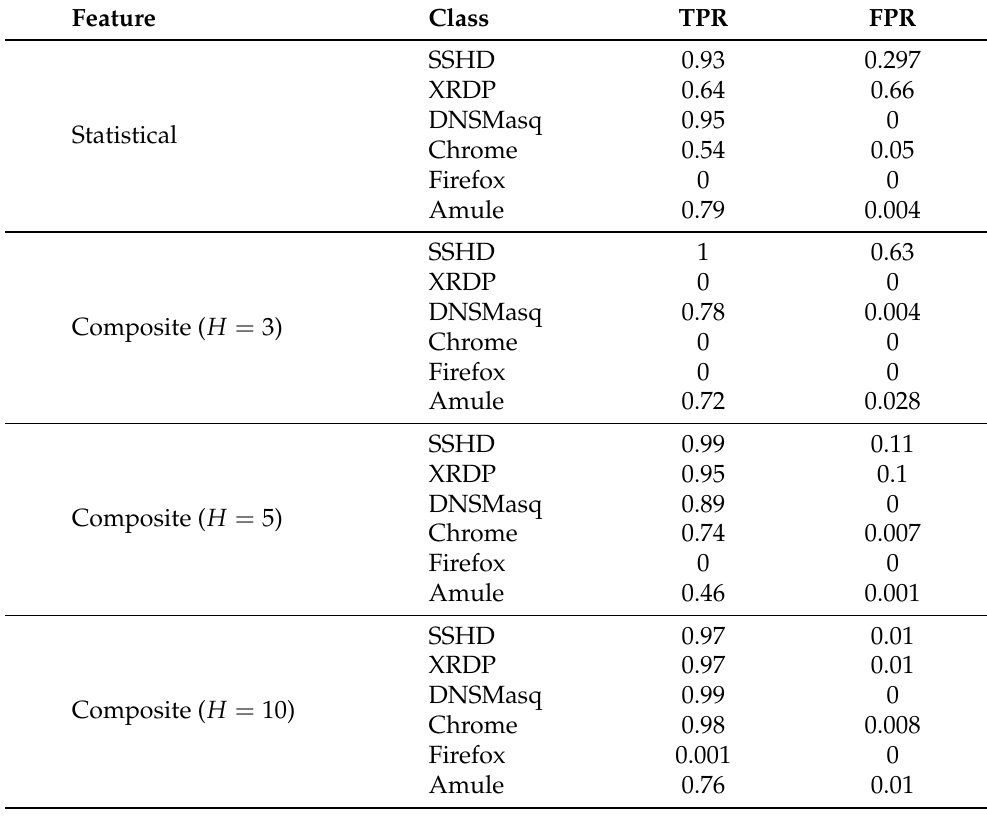
Table 6. SVM: TPR and FPR over UPC data set.